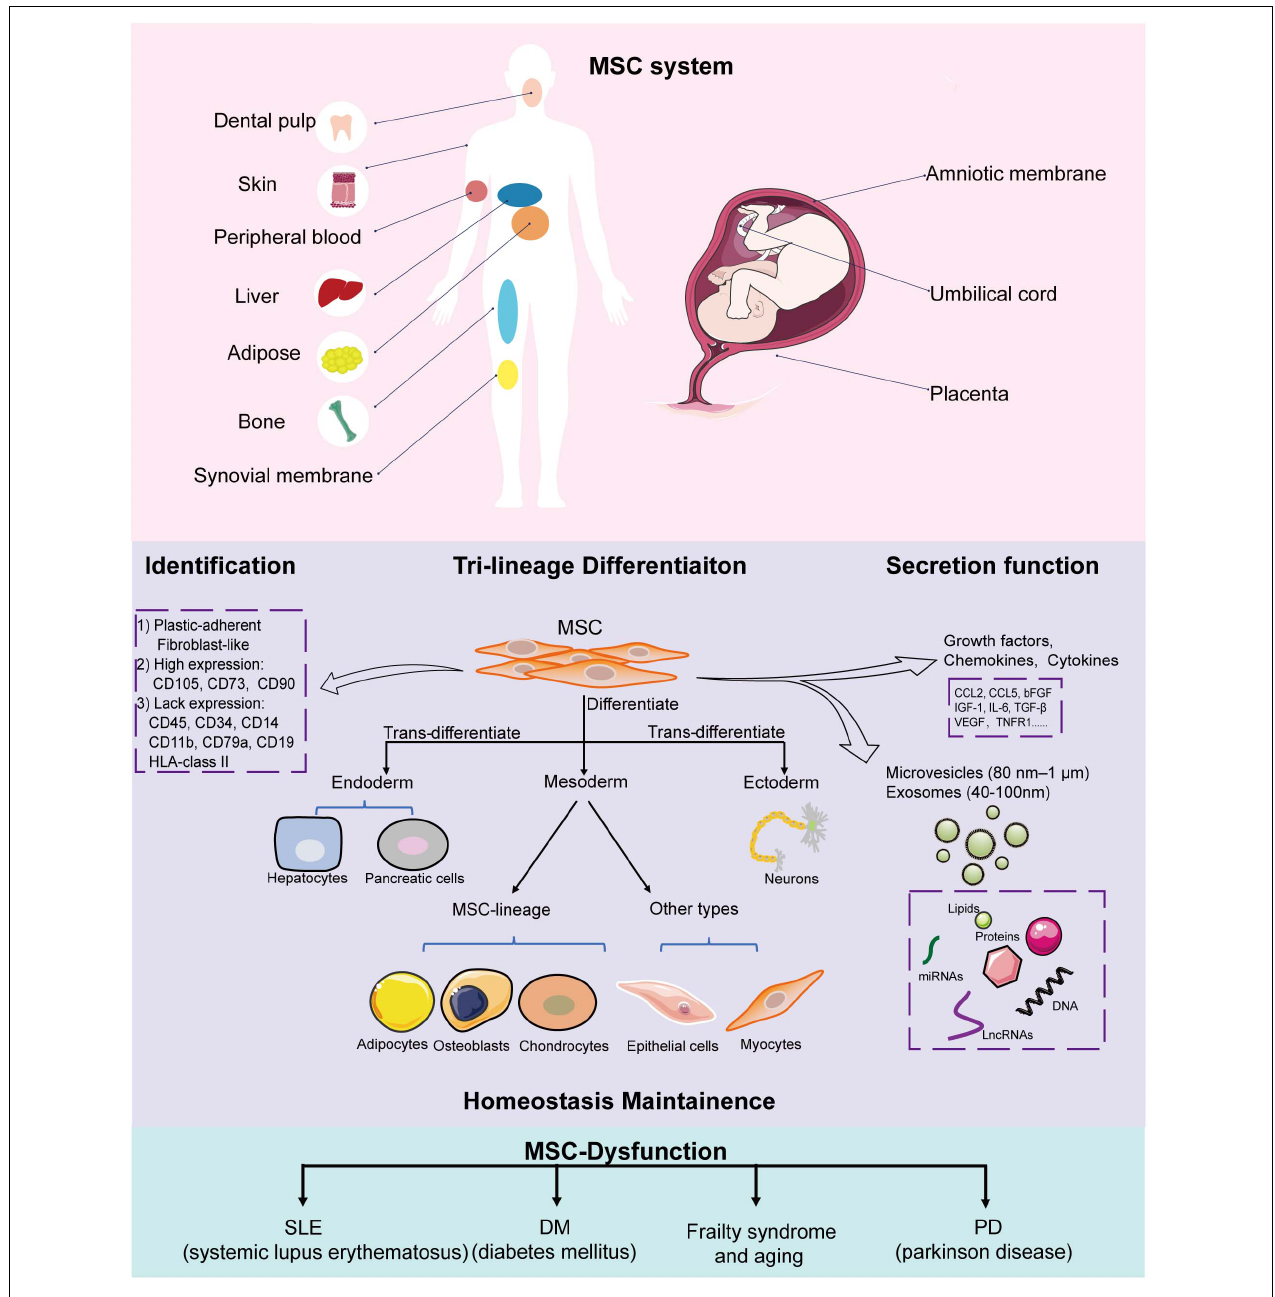
FIGURE 1 | Implications of MSCs in homeostasis. MSCs can be isolated from a variety of tissues, including the amniotic membrane, umbilical cord, placenta, adipose tissue, skin, peripheral blood, dental pulp, and fetal liver. All MSCs derived from different stages of embryonic development, from postembryonic sub-totipotent stem cells to progenitors, are defined as MSC systems. During in vitro culture, MSCs must: (1) be fibroblast-like and plastic-adherent; (2) express CD105, CD73, and CD90, and lack CD45, CD34, CD14 or CD11b, CD79a or CD19, and HLA class II expression; (3) differentiate into adipocytes, osteoblasts, and chondroblasts. MSCs have trilineage differentiation potential, can secrete bioactive molecules and EVs (microvesicles and exosomes) to help tissue repair and maintain homeostasis. MSC dysfunction leads to disease-related MSC alterations that induce homeostasis disorder systemic